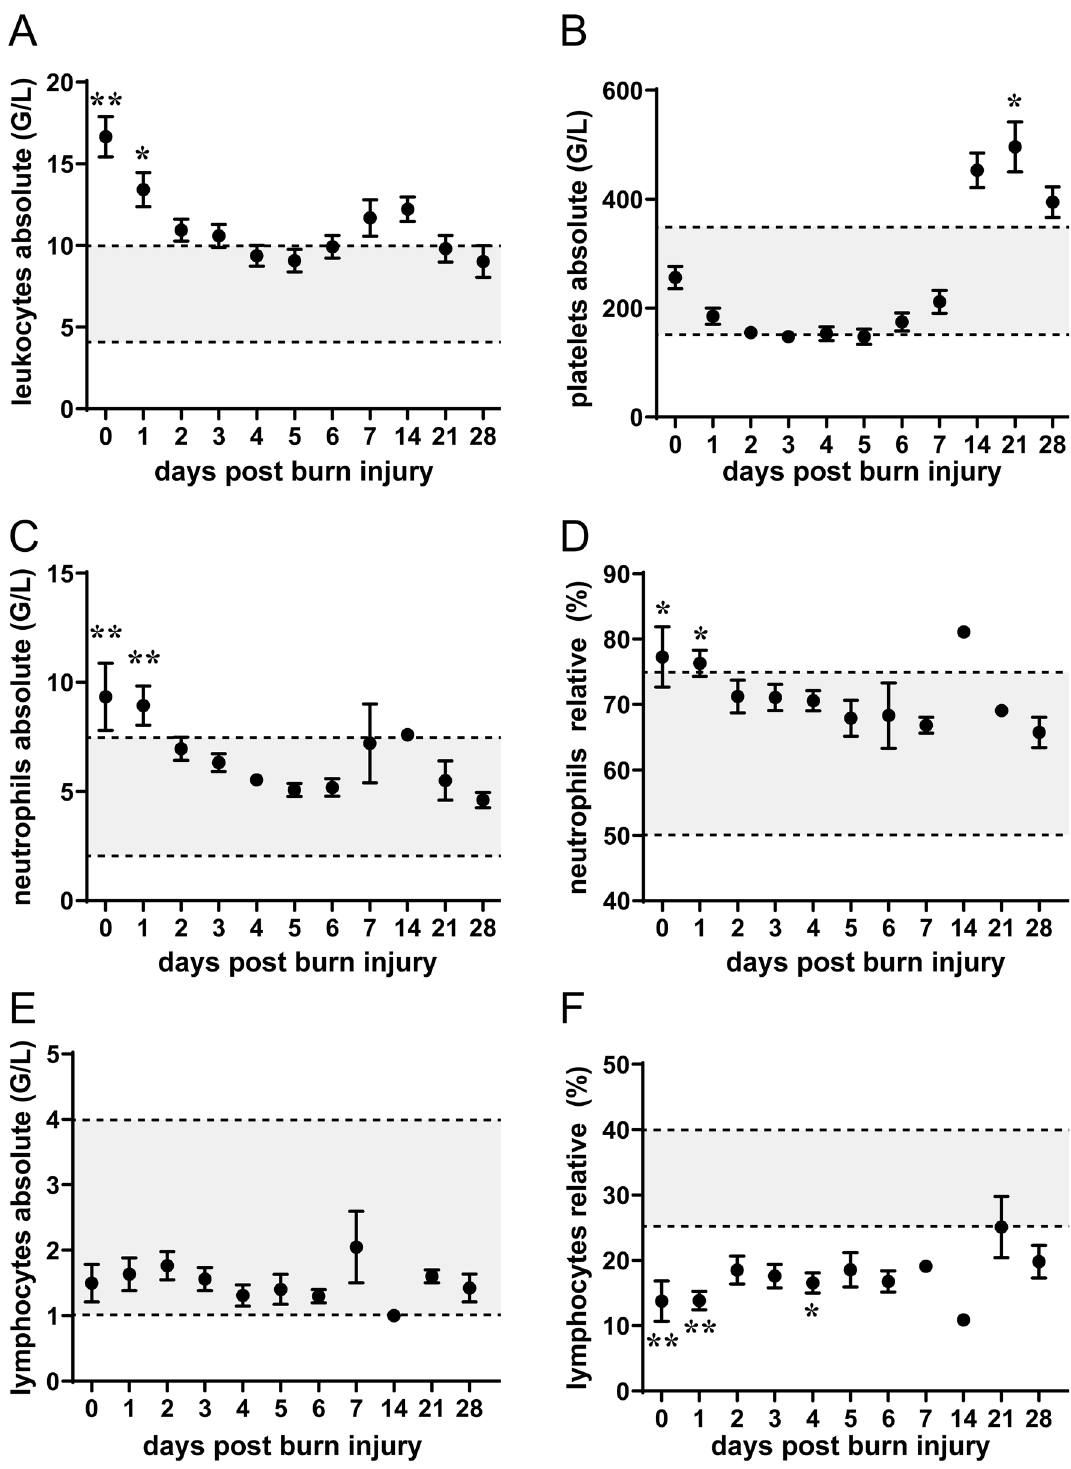
Figure 2. Immune cell counts up to 4 weeks post injury. Patient data in relation to established in-hospital reference standards (n = 1–31). Data are presented as means ±